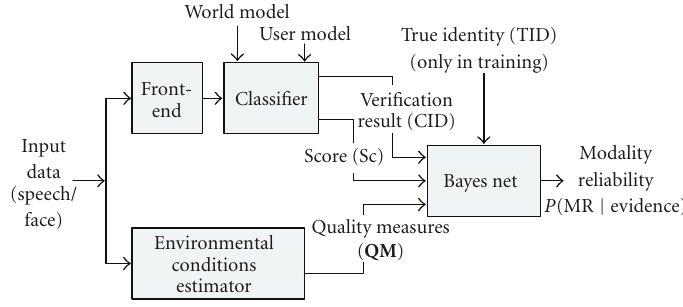
Figure 2: Modality expert with modality classifier and modality reliability